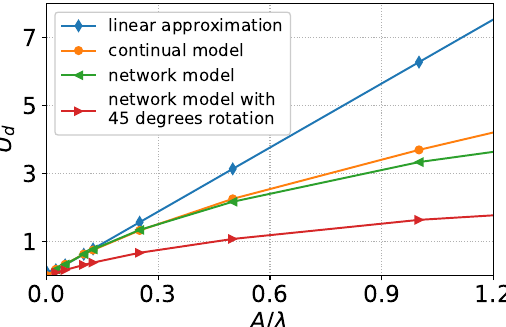
Figure 10. Growth rate calculation results: blue line—linear approximation; orange line—continual model; green line—network model; red line—network model with 45 degrees